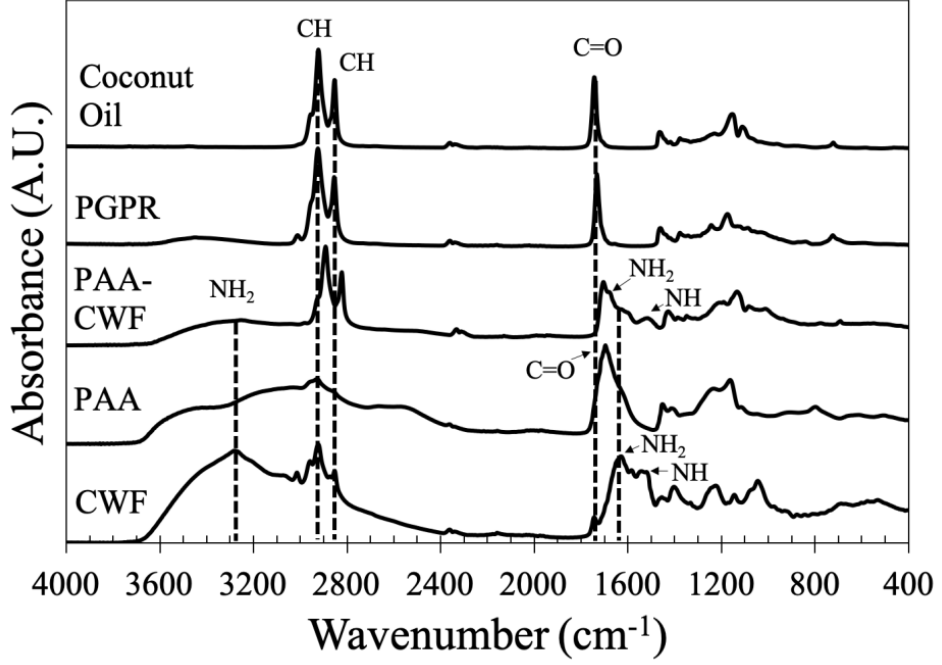
Figure 4. FT − IR spectra of polyacrylic acid/ Schizochytrium sp. (PAA/Schizo) microgels and their components: cell wall fraction (CWF), polyacrylic acid (PAA), polyglycerol polyricinoleate (PGPR) and coconut oil.